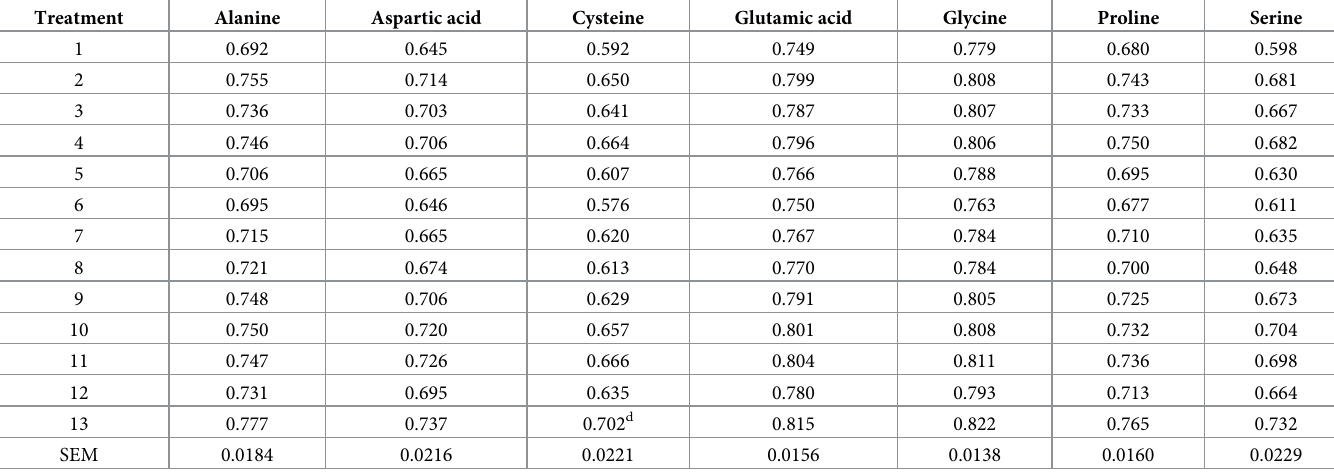
Table 11. Effects of dietary treatments on apparent ileal digestibility coefficients of non-essential amino acids at 28 days post-hatch.